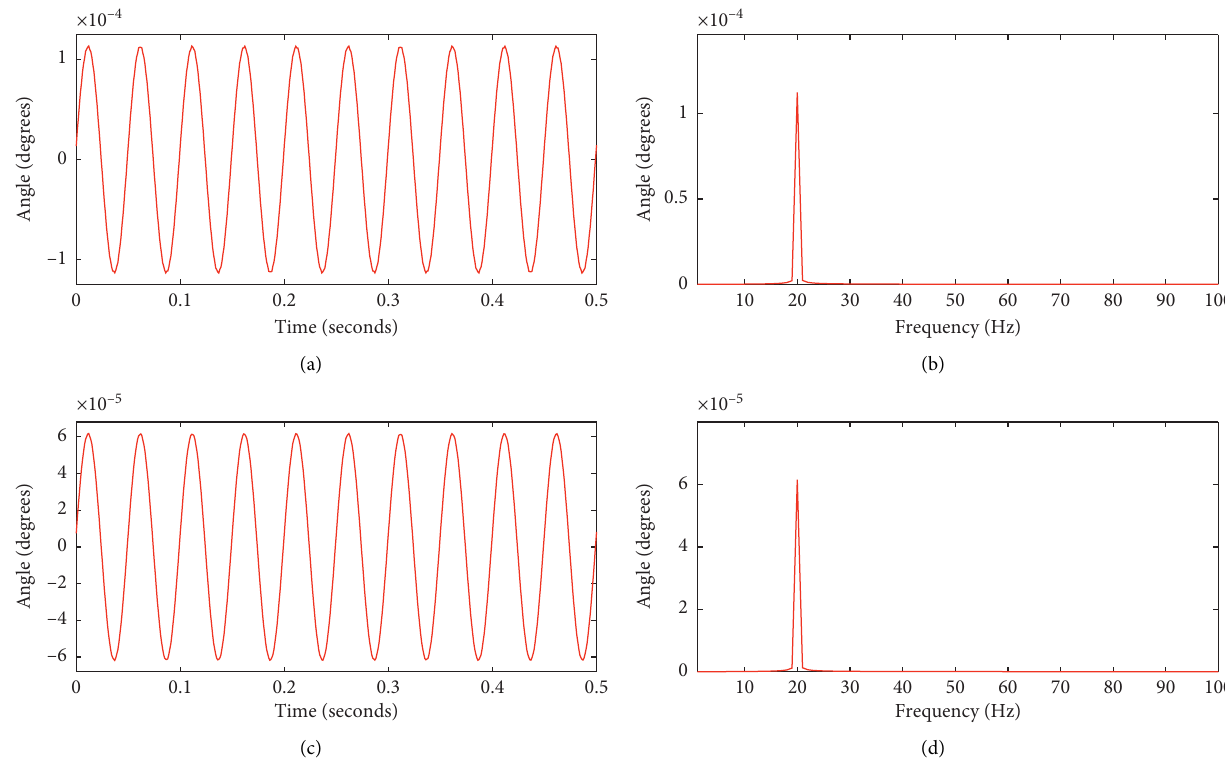
Figure 10: Time- and frequency-domain response of the unbalanced system in angular directions θ Frequency response of θ